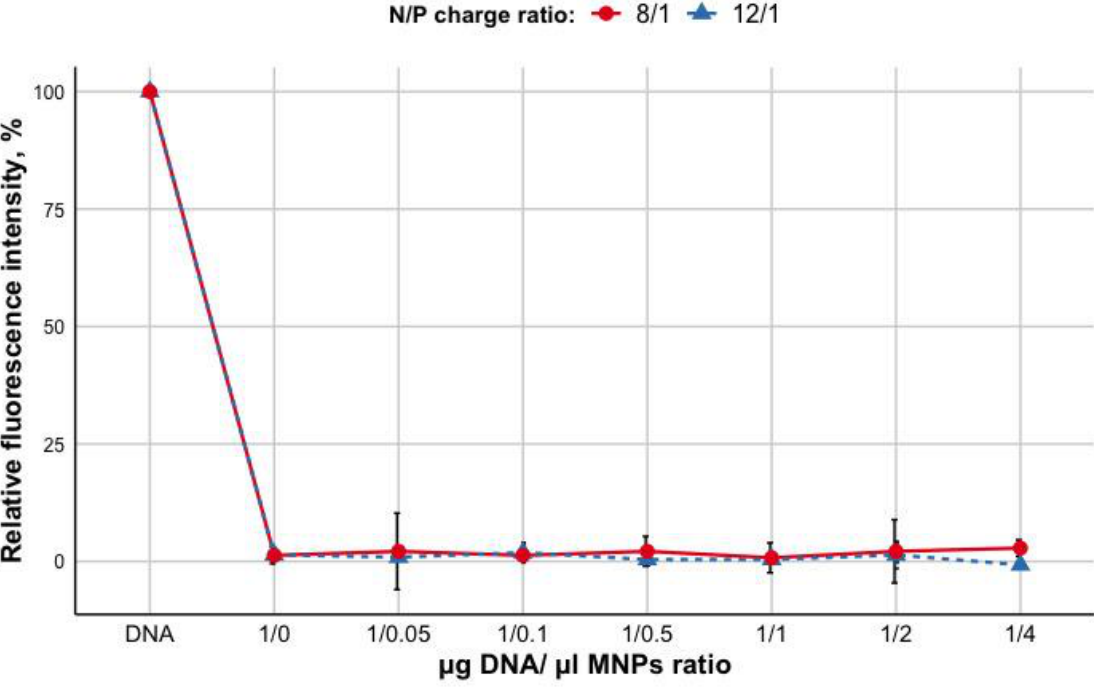
Figure 1. Ethidium bromide (EtBr) exclusion from R6p-cRGD/DNA polyplexes with an increasein MNPs content. Values are the mean ± S.D. of triplicate experiments.